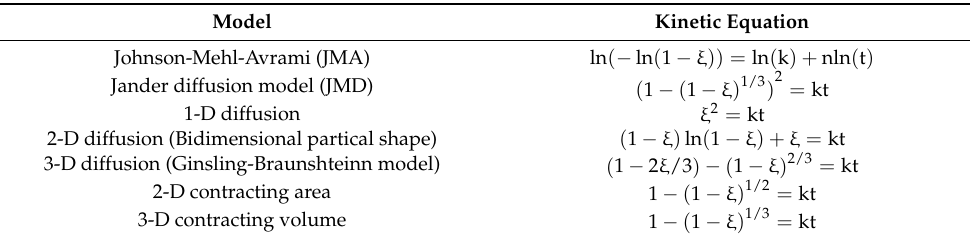
Table 5. Kinetic models applied for hydrogenation. (Reproduced with permission from ref. [71]. Copyright 2014